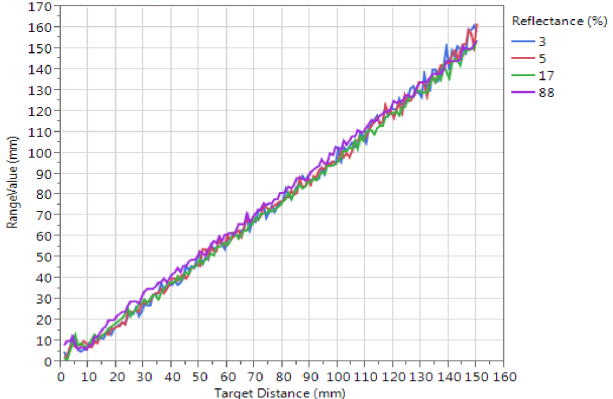
Figure 3. Typical ranging performance of the VL6180X proximity sensor, provided by STMicroelectronics (Geneva, Switzerland) [27], for different target reflectance (3%, 5%, 17% and 88%) by varying the range from 0 to 150